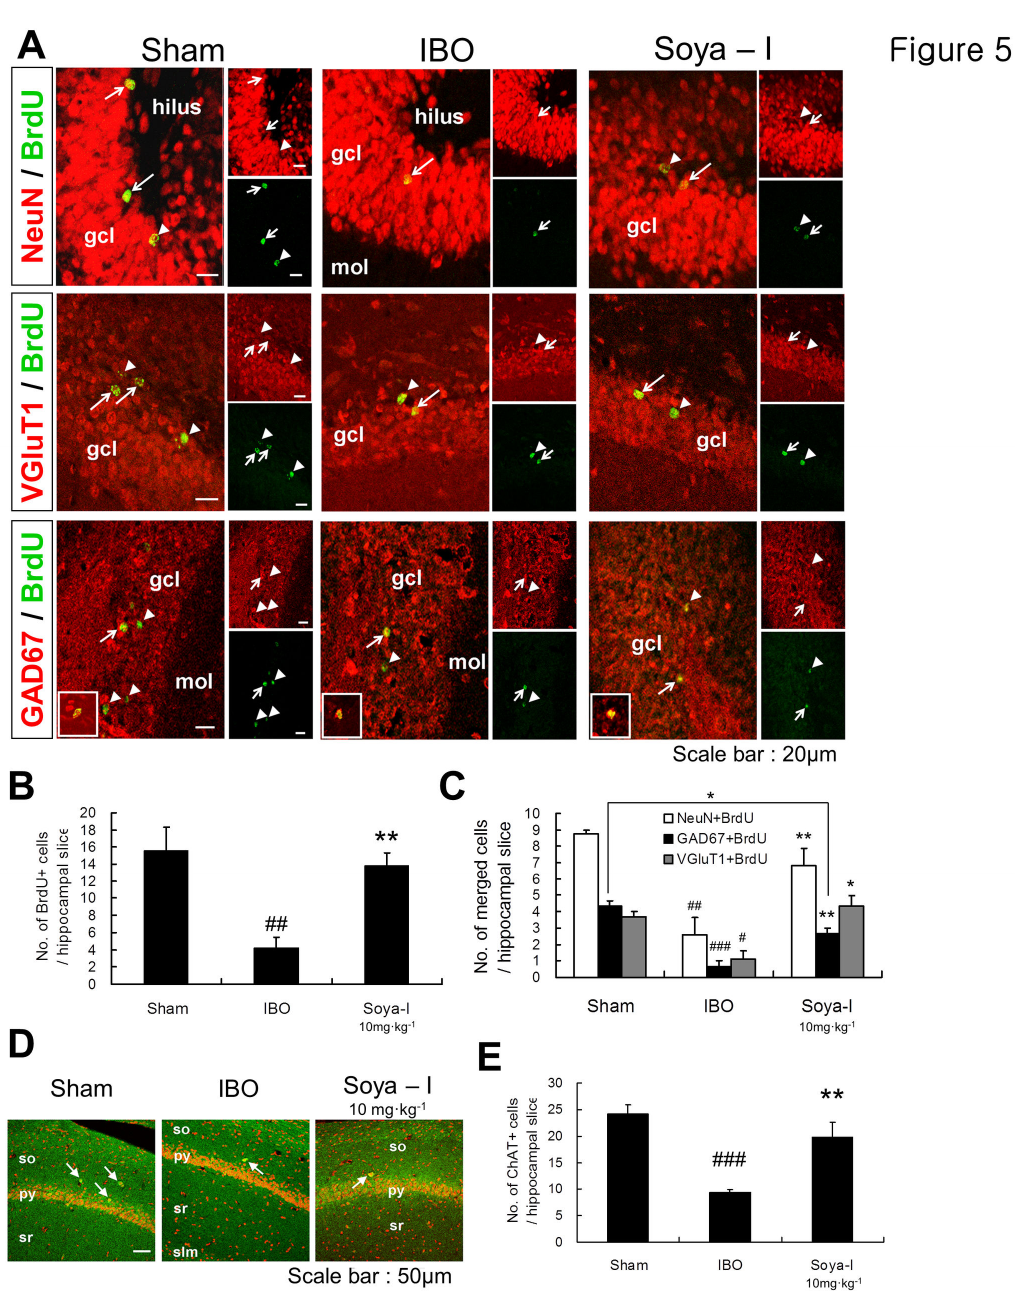
Figure 5. Differentiation of new-born NPCs to neuronal cell types induced by soya-Ι administration. A. Confocal laser scanning microscopic images of neuronal cells merged with isotype cell markers in the granular cell layer of brain slices (green: BrdU-positive cells, red: VGluT1, GAD67, and NeuN). Arrow heads = non-merged cells, arrows = merged cells (the image below left; BrdU and GAD67-double positive cells). B. Average numbers of BrdU-positive cells per hippocampal slice. C. Average numbers of NeuN-, VGluT1-, and GAD67-positive cells merged with BrdU-positive cells per hippocampal slice. D. Confocal laser scanning microscopic images of ChAT-positive cells (arrows) in the hippocampal region of brain slices (green: ChAT-positive cells, red: PI). Abbreviations: so, stratum oriens; py, pyramidal layer of CA1; sr stratum radiatum; slm, stratum lacunosum moleculare. E. Average numbers of ChAT-positive cells in the hippocampal region per brain slice. Immunohistochemical assay and counting were carried out as described in the Materials and Methods. Five different animals were used for each treatment group. Data represent means ± SEM ( # p < 0.05, ## p < 0.01, ### p < 0.001, compared with the sham group, * p < 0.05, ** p < 0.01, compared with the IBO group by the Newman-Keuls Multiple Comparison Test). doi: 10.1371/journal.pone.0081556.g005 PLOS ONE |